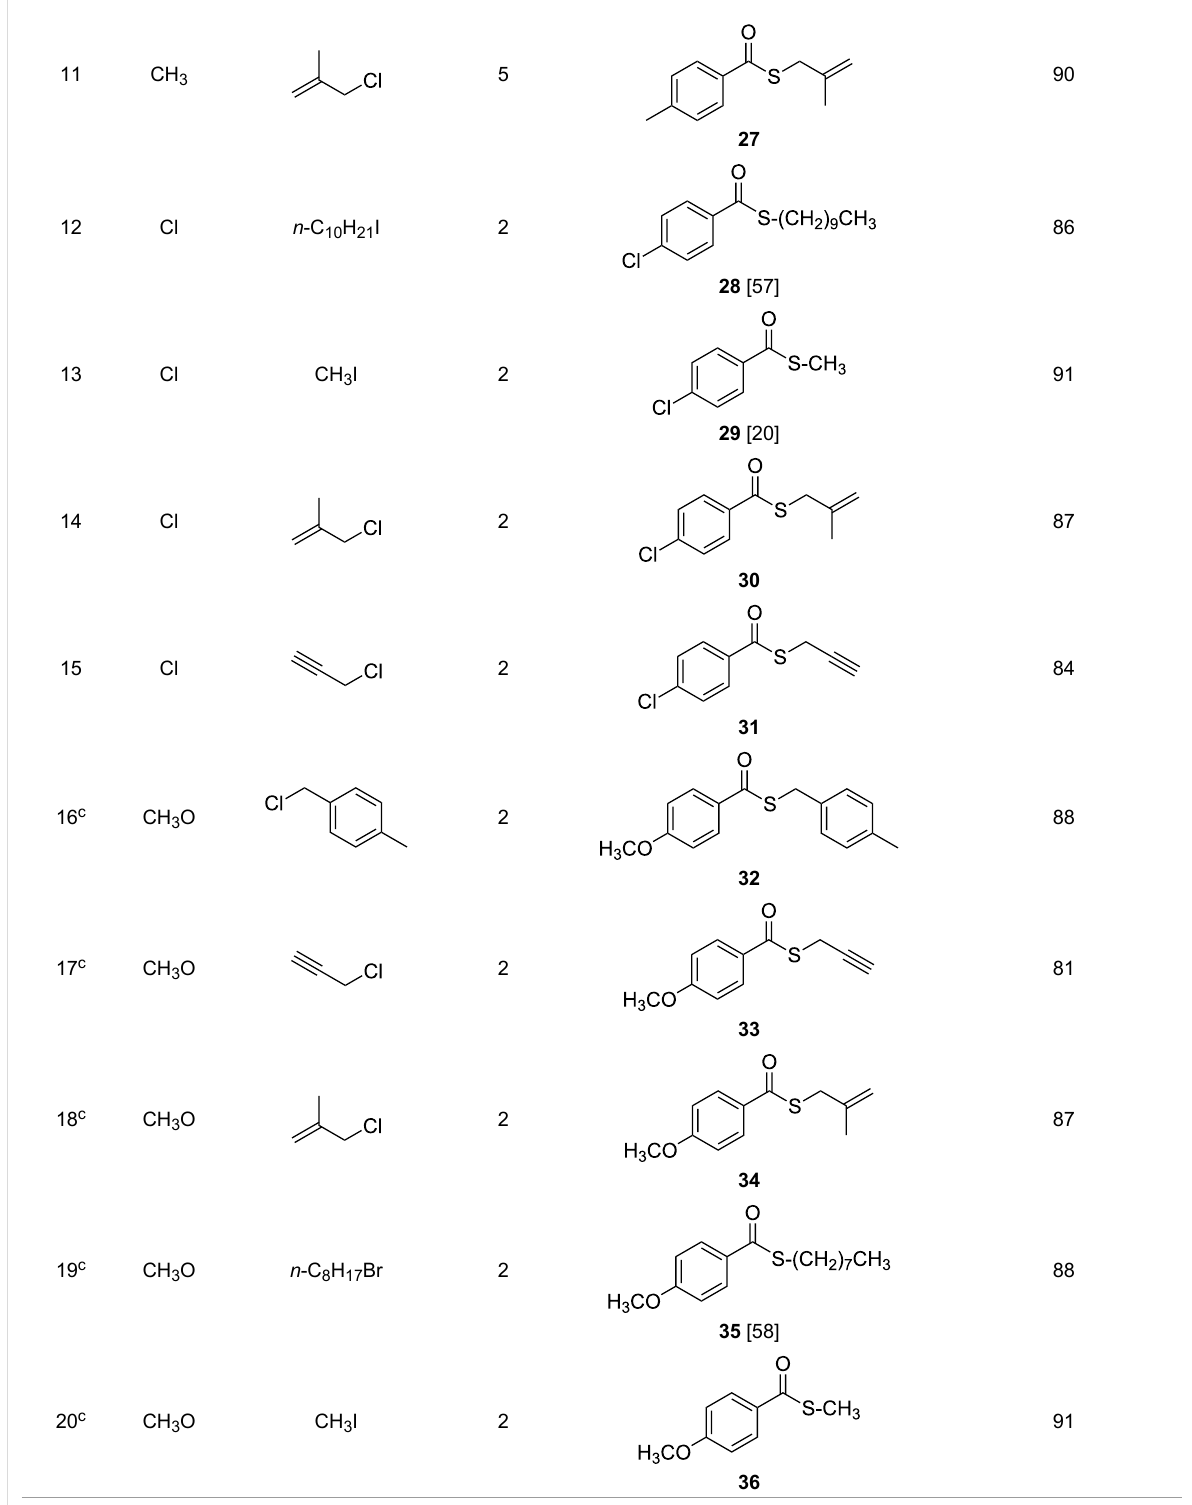
Table 2: One-pot synthesis of thioesters using benzoic anhydrides, thiourea and alkyl halides a .